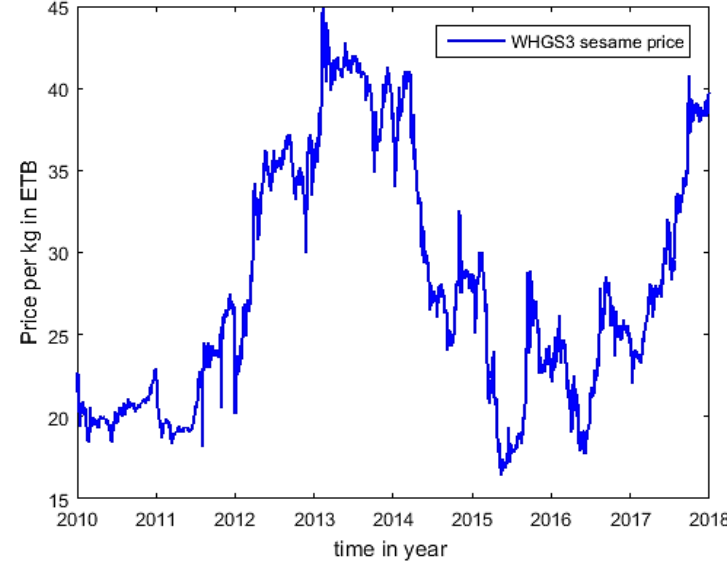
Figure 1. The WHGS3 sesame price from 2010 to